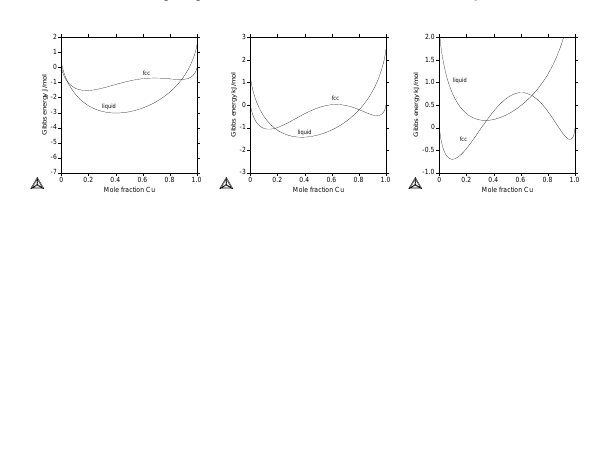
The diagrams below show the modelled Gibbs energy functions for two phases in a binary system at 3 different